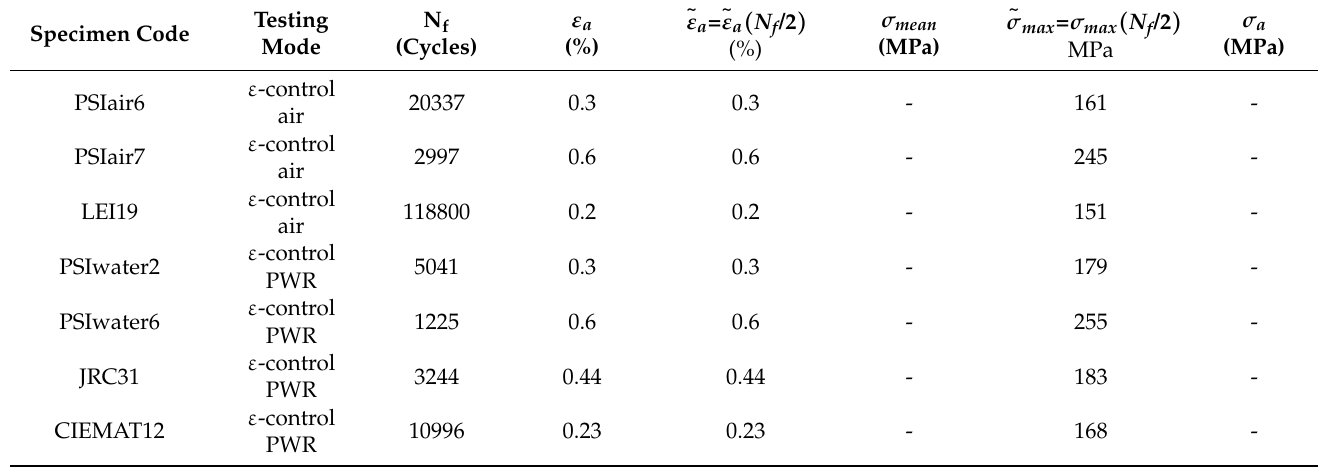
Table A2. Fatigue data of the INCEFA-PLUS main program used in this